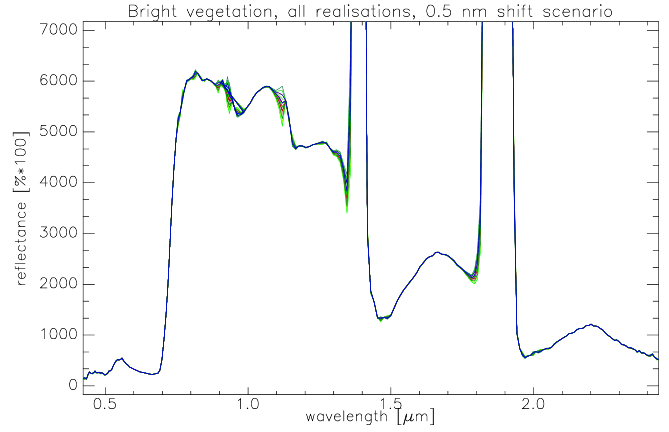
Figure 12. Plot of all realisations for the ROI “bright vegetation”.